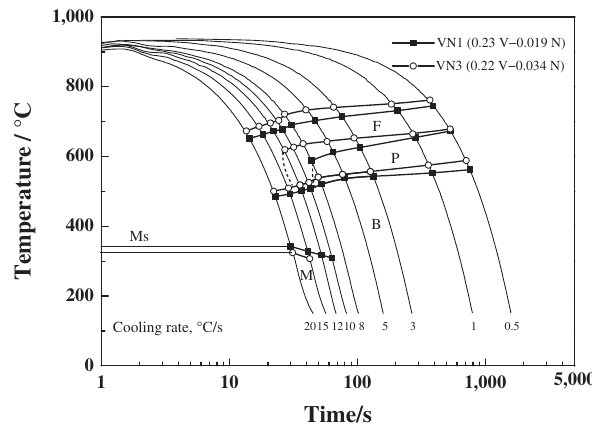
Figure 6: Comparison between the CCT diagrams obtained for chemical compositions: nitrogen content from 0.019 mass% to 0.034 mass%.